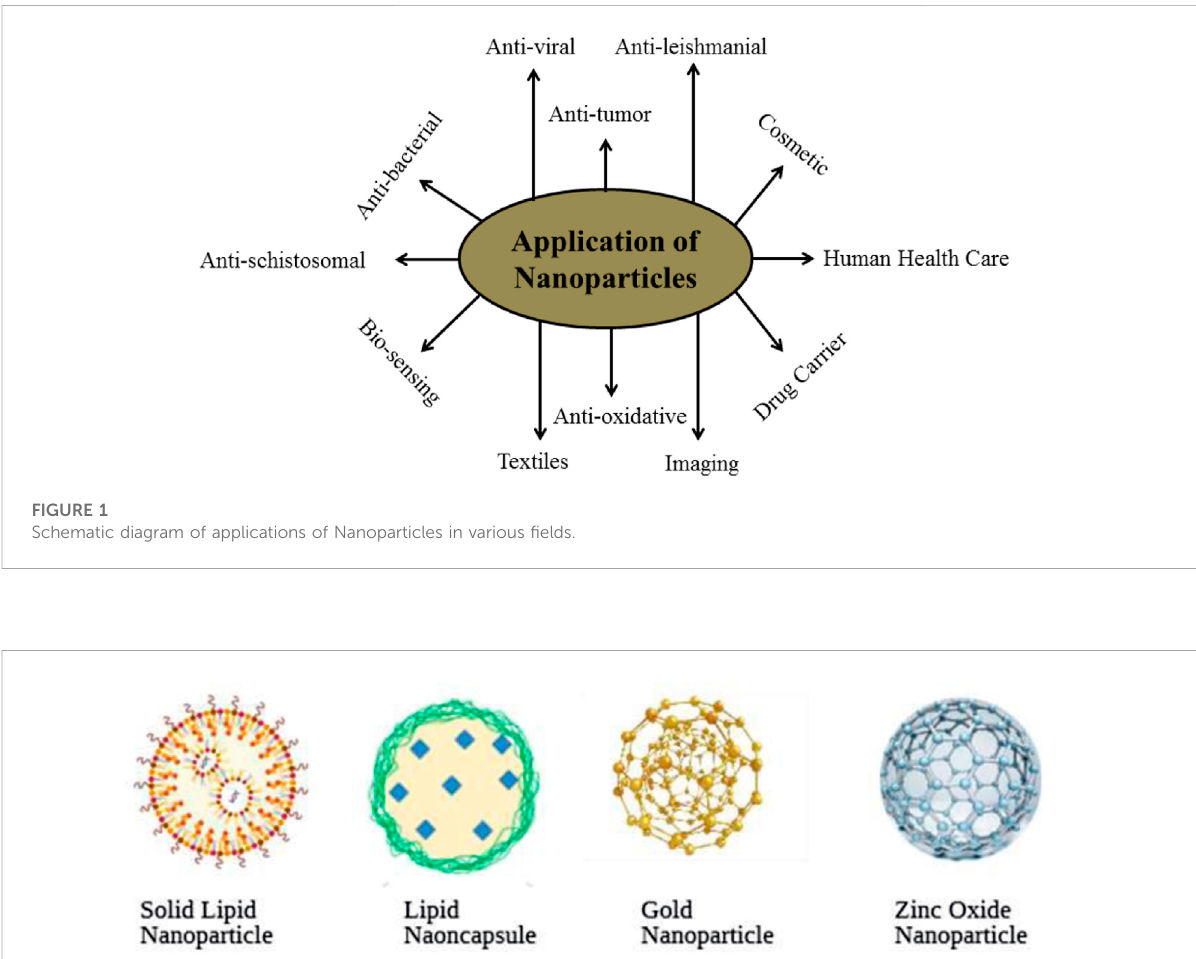
Frontiers in Bioengineering and